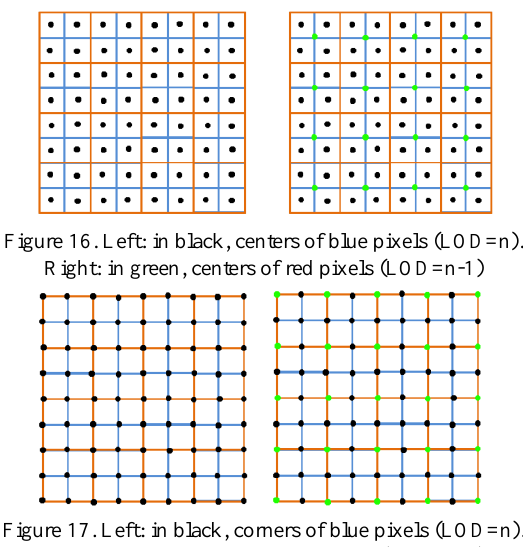
Figure 17. Left: in black, corners of blue pixels (LOD=n). Right: in green, corners of red pixels